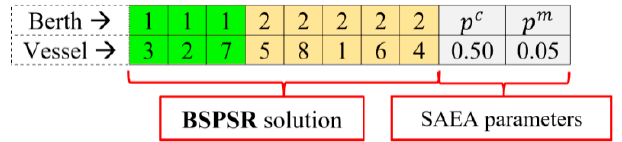
Figure 4. An example of the SAEA chromosome representation.